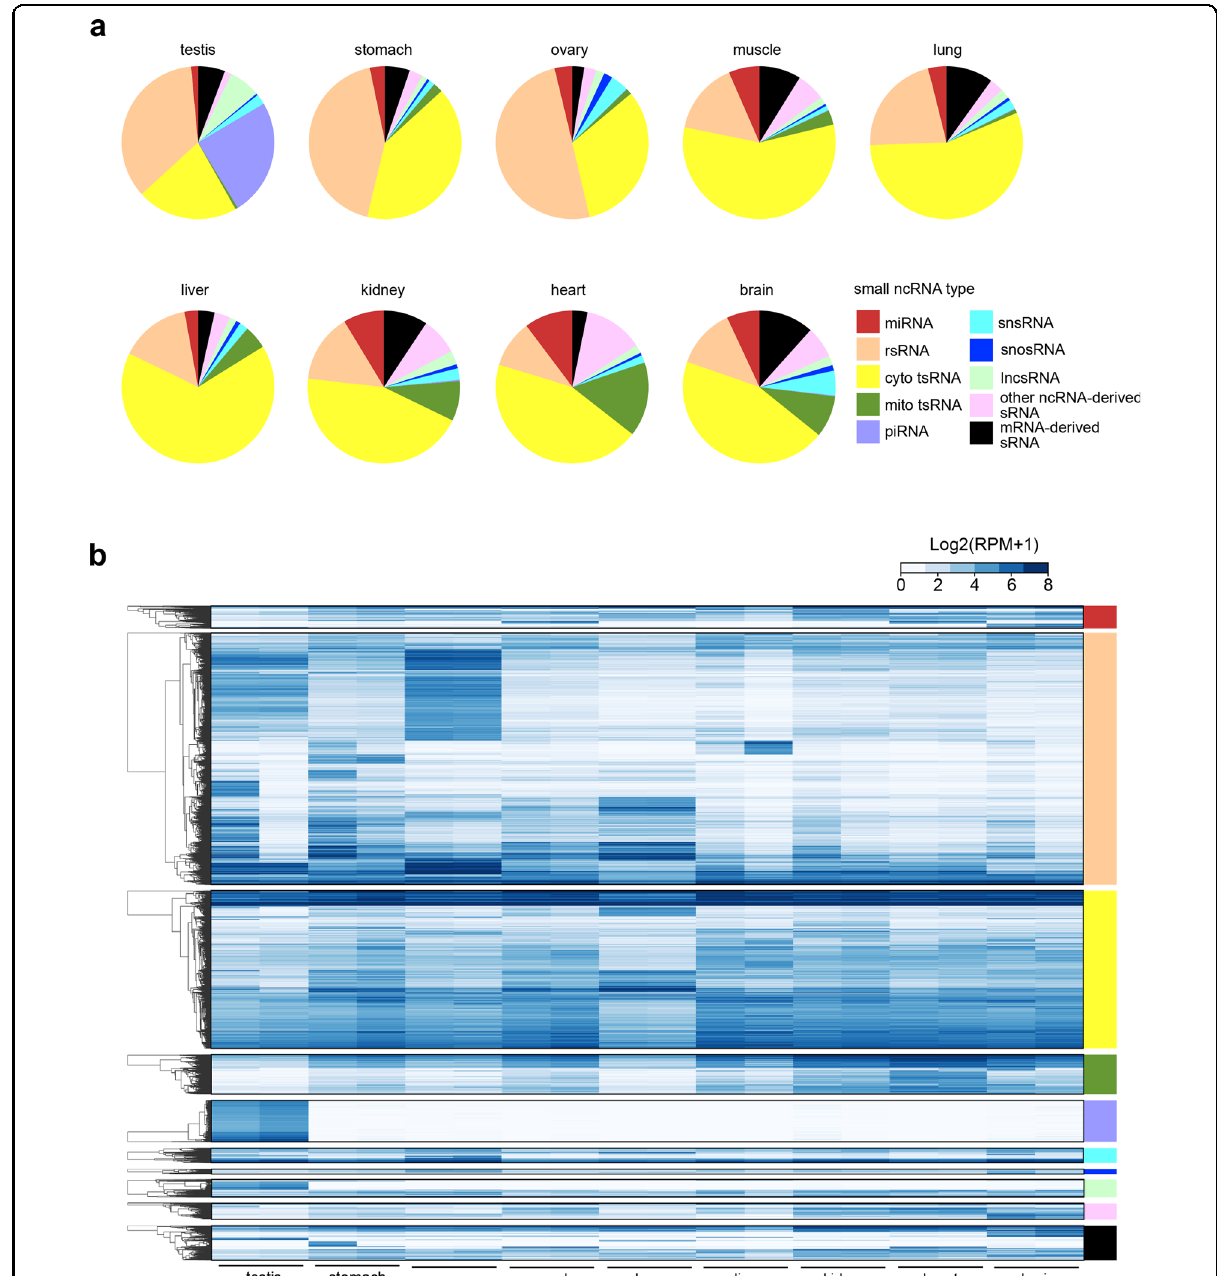
Fig. 5 sRNomes across different mouse tissues. a Coverage of sRNA types across different mouse tissues as pro fi led using CPA-seq. b Hierarchical clustering of unique reads (RPM > 20 in at least one tissue) from the indicated mouse tissues. For hierarchically-clustered analysis, the unique reads were fi rst classi fi ed according to the sRNA type. Then the average Euclidean distance for log 2 transformed unique reads of each type of sRNA was